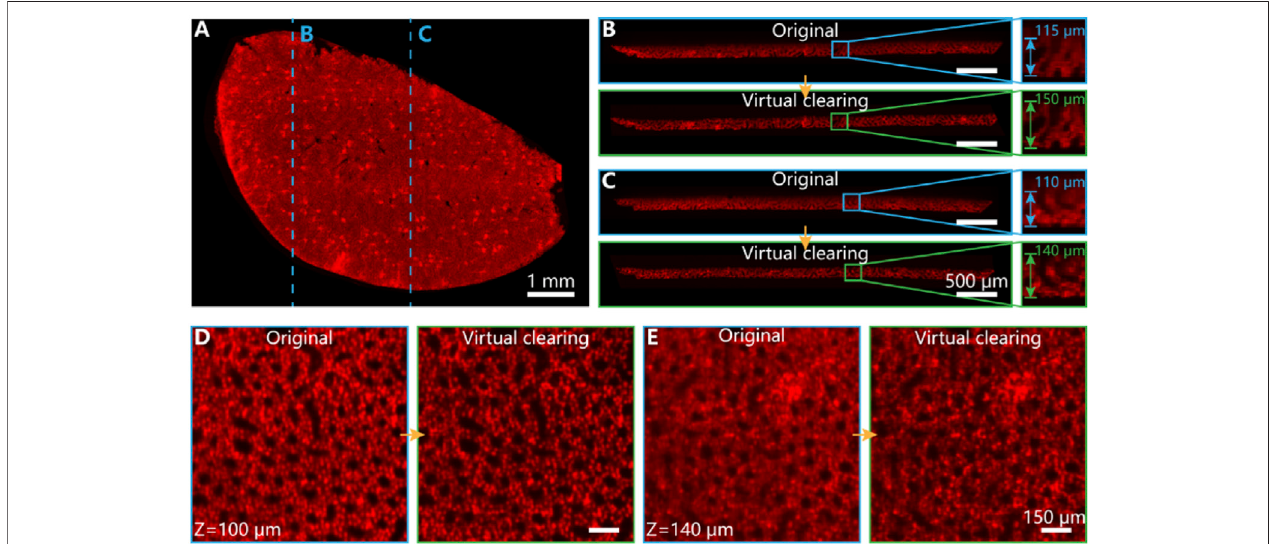
FIGURE3| The image information restorationeffect in amouse kidney tissue slice. (A) Fluorescence image ofamouse kidney slicelabelled withcell nucleus (B,C) Thecomparisonofclearingextentbetweenoriginaland fl uorescenceimageprocessed by3D-VoCycleGAN. (D,E) Theimageimprovementsindifferentimagingdepths. The image of z = 100 μ m was given in (D) and image of z = 140 μ m was given in (E) .